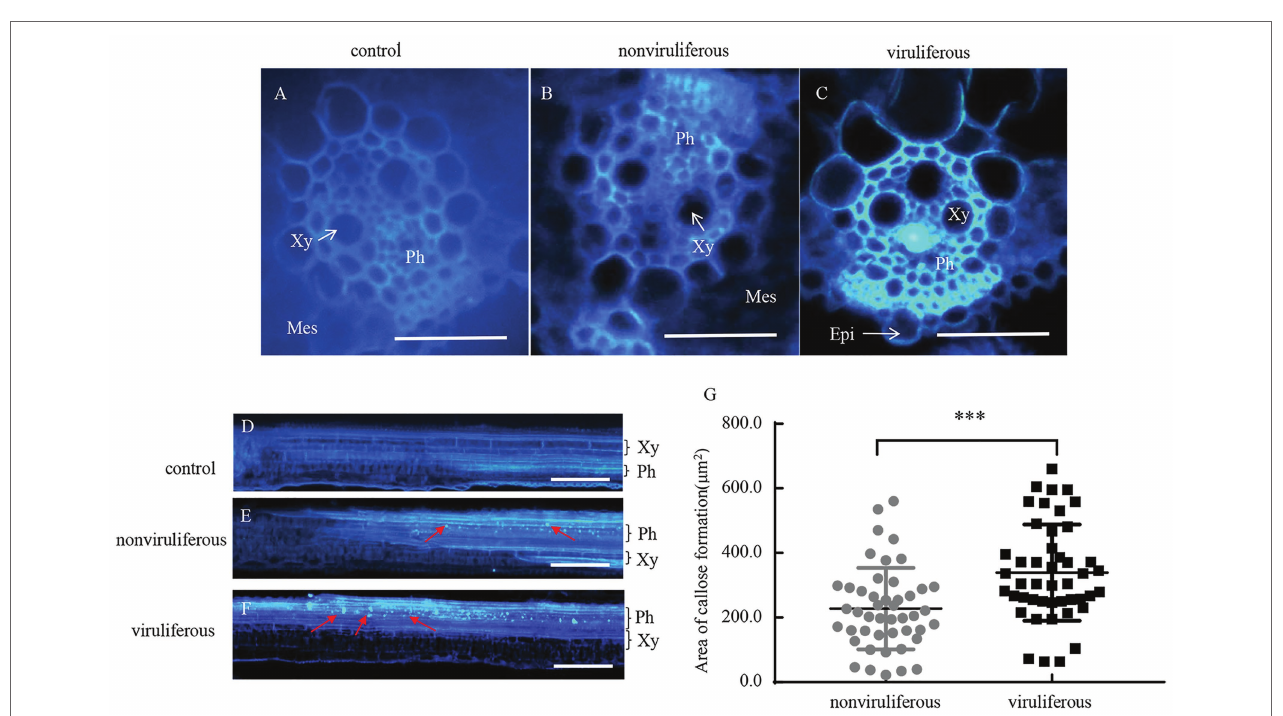
FIGURE 5 | Infection of RGDV by R. dorsalis activated the callose deposition in rice phloem. (A–F) Induced callose deposition in the phloem depicted by bright blue fluorescence in the cross-sections (A–C) and longitudinal-sections (D–F) prepared from leaf phloem infested with nonviruliferous or viruliferous R. dorsalis . The sample without insect infestation served as the control. The thin sections were stained with 0.1% aniline blue at 3 days after R. dorsalis feeding and examined under a fluorescence microscope. Xy, xylem; Ph, phloem; Mes, mesophyll; Epi, epidermis. Arrows indicate the bright blue fluorescence. Scale bars: 50 μ m. (G) The average areas of sieve plates with callose deposition in nonviruliferous or viruliferous R. dorsalis -infested leaf sheaths were counted using Image J. Error bars denote ± SE of sieve plates with callose deposition observed in 46 cross-sections. Significant differences in callose deposition are denoted as *** ( p , 0.001); student’s t